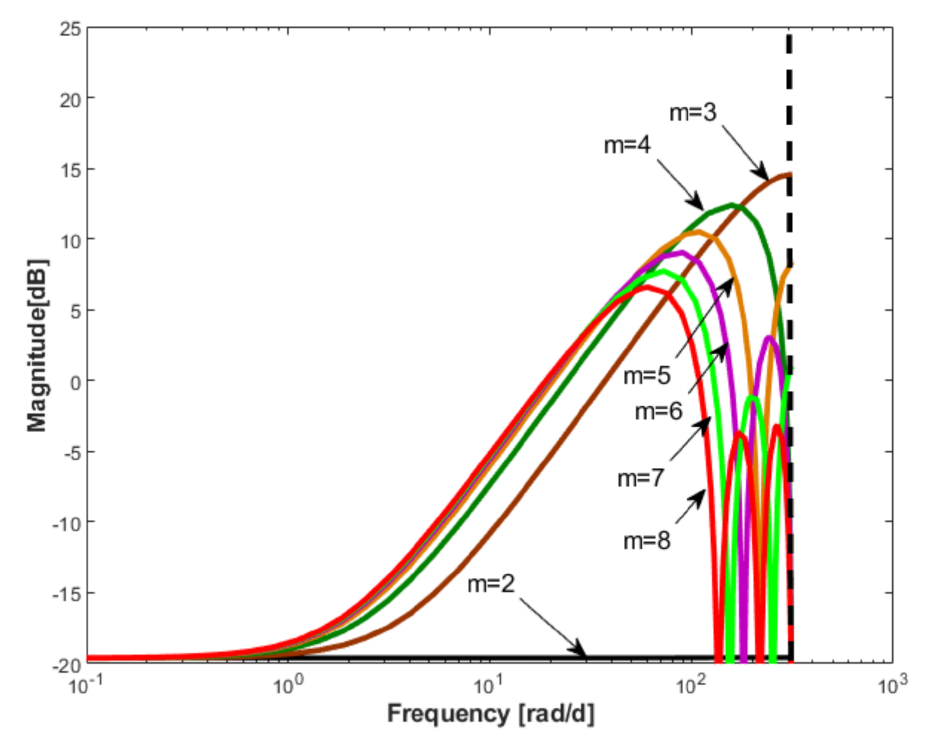
Figure 8. The Bode characteristics of the Q ( z, θ ) for (cid:101) ω = 2.5 [ rad/d ] and m = 2, . . .